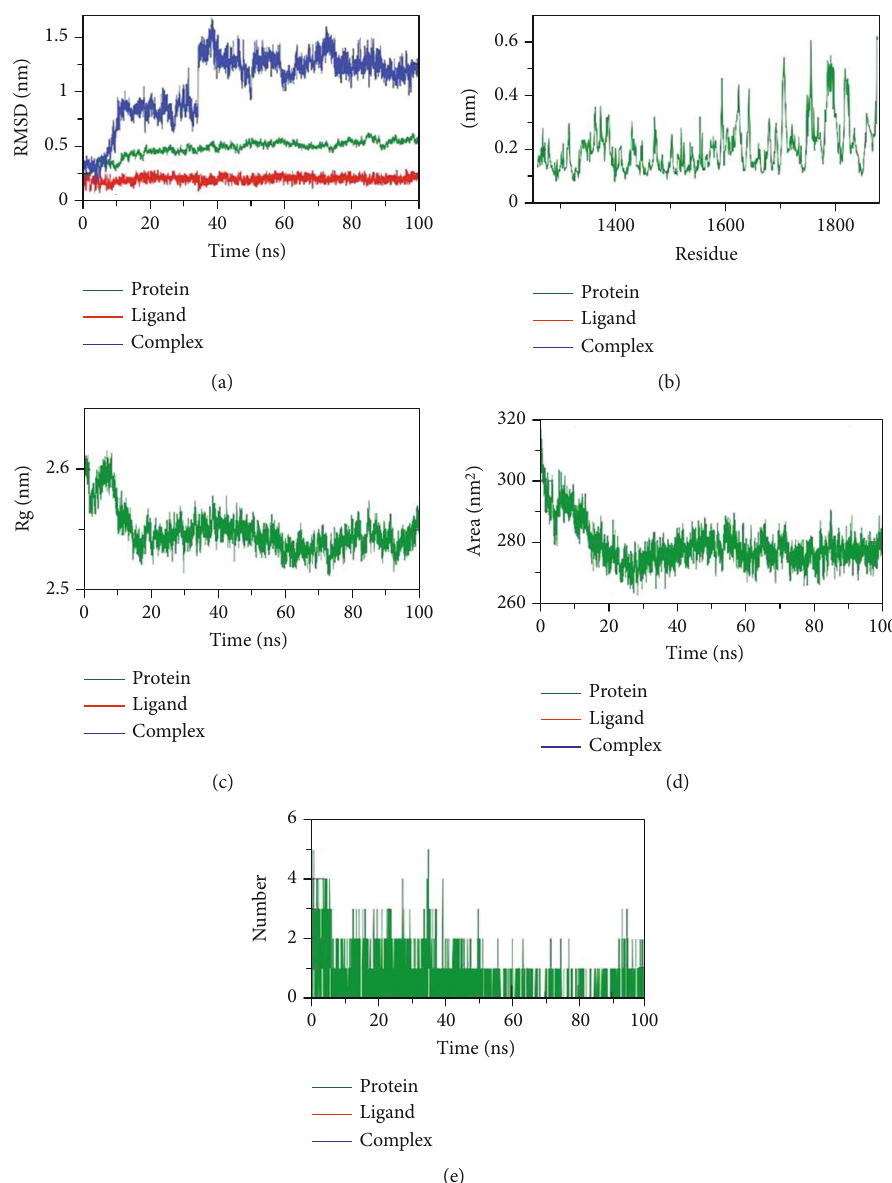
Figure 17: MD simulation trajectory analysis of (a) root mean square deviation (RMSD) of proanthocyanidin-C1 bound with 7T9K at 100- ns time frame, (b) root mean square fl uctuation (RMSF), (c) radius of gyration (Rg), (d) solvent accessible surface area plot of proanthocyanidin-C1 bound with 7T9K at 100-ns time frame, and (e) number of H-Bond plot of proanthocyanidin-C1 bound with 7T9K at 100ns time